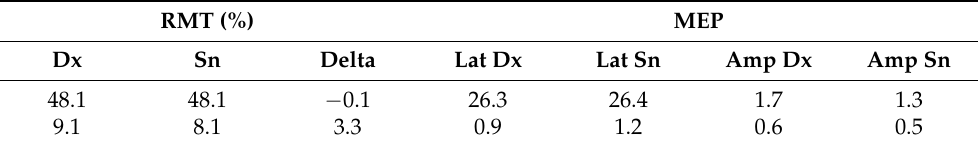
Table 1. TMS-estimates excitability